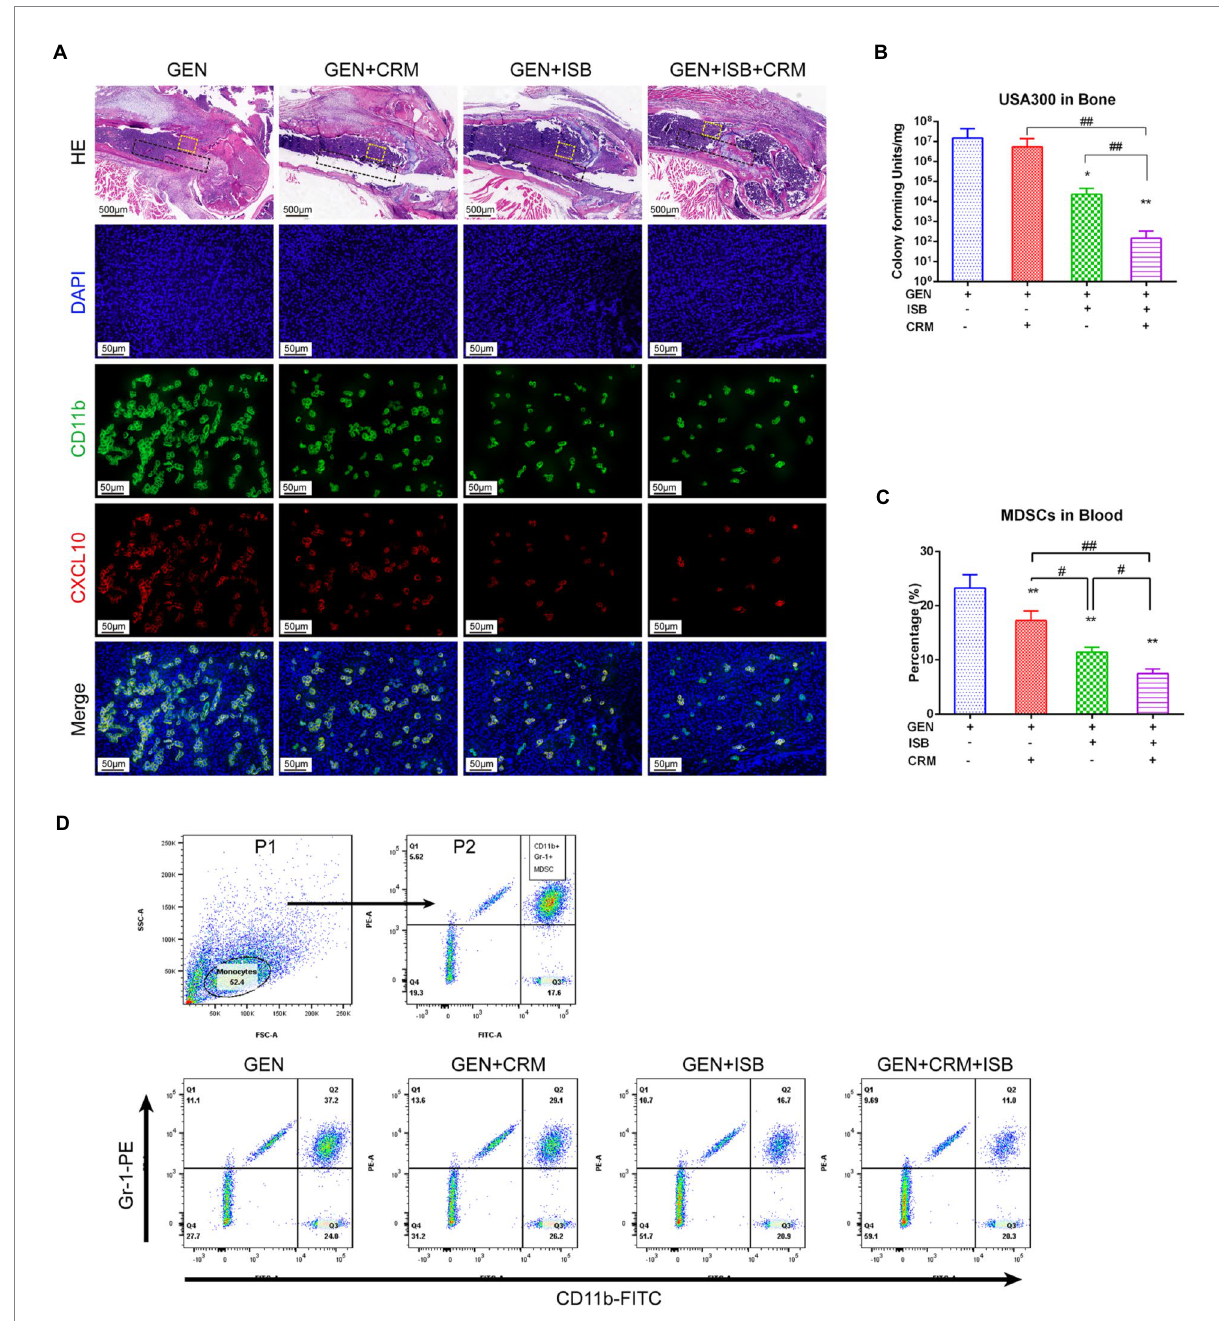
FIGURE 7 Cocktail therapy of Gentamicin with Isobavachalcone and Curcumin alleviate local tissue inflammation, enhance reduction of MDSC M1 Polarization and Eradication of MRSA biofilm in vivo . (A) HE and immunofluorescent staining of distal femur suggest reduction of tissue inflammation and M1 polarization of MDSC, green represents CD11b, a key marker to identify MDSC, while red represents CXCL10, a key marker of activated M1, he black dashed box indicates the approximate location of the implant, and the yellow dashed box range is the area where M1- polarized MDSC in the adjacent implant tissue is observed. (B) Quantification of remaining MRSA in bone with implant. (C) Flow cytometry analysis showed reduction of MDSC in peripheral blood by Gentamicin with ISB or CRM and cocktail therapy. (D) Gating strategy for flow cytometry analysis and representative analysis of frequency of MDSC in peripheral blood. All data were presented as mean ± SD, * represents p < 0.05 and ** represents p < 0.01 when compared to Gentamicin group; # represents p < 0.05 and ## represents p < 0.01 when GEN + ISB + CRM group compared to GEN + ISB/CRM group; GEN, 20 mg/kg/day Gentamycin; ISB, 20 mg/kg/day Isobavachalcone; CRM, 20 mg/kg/day